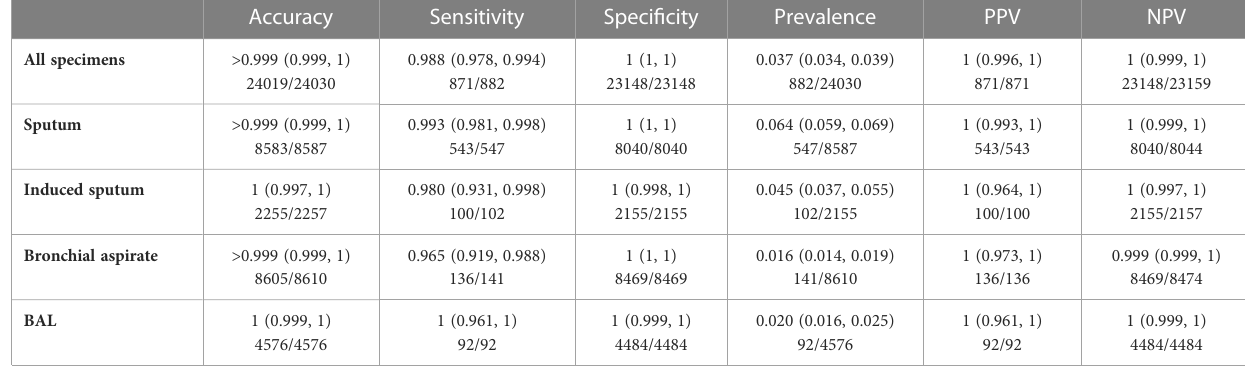
TABLE 3 Performance of culture for the diagnostic of pulmonary tuberculosis according to the type of specimen. Accuracy Sensitivity Speci fi city